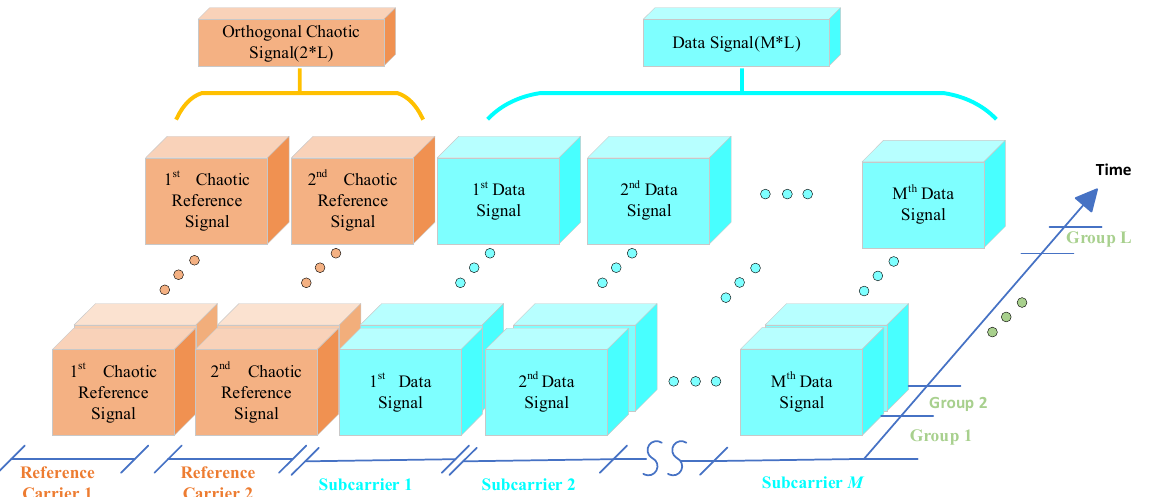
Figure 5. Format of the signal transmitted in the MC − ODBR − DCSK system.